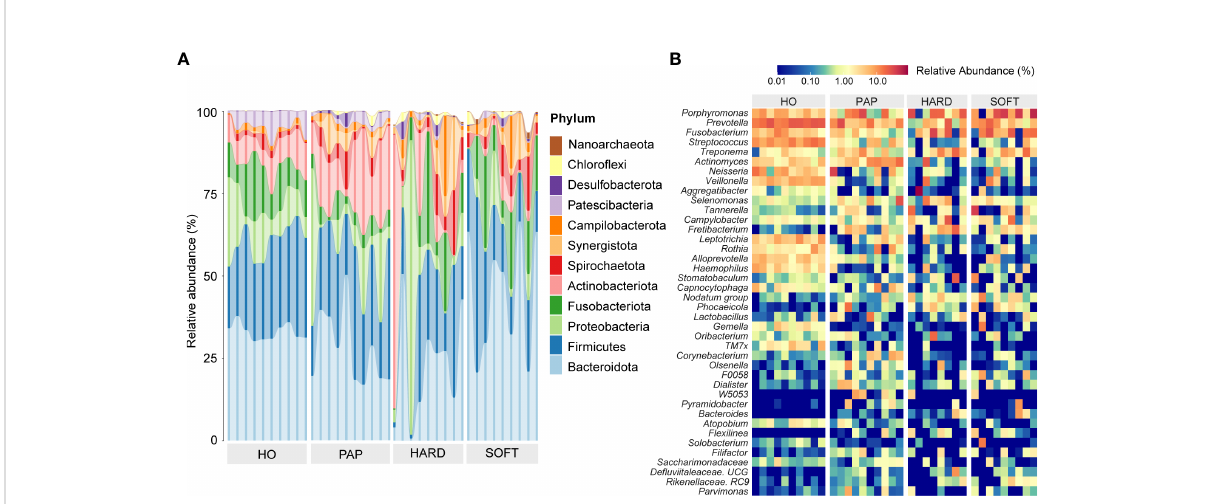
FIGURE 1 The phylogenetic pro fi ling of microbiotas in healthy oral (HO), primary apical periodontitis (PAP), and persistent apical periodontitis (AP). Samples of persistent AP were classi fi ed into root apex (HARD) and periapical granulation tissues (SOFT). (A) Relative abundance of major microbial species at the phylum level. (B) Heatmap of relative abundance at the genus